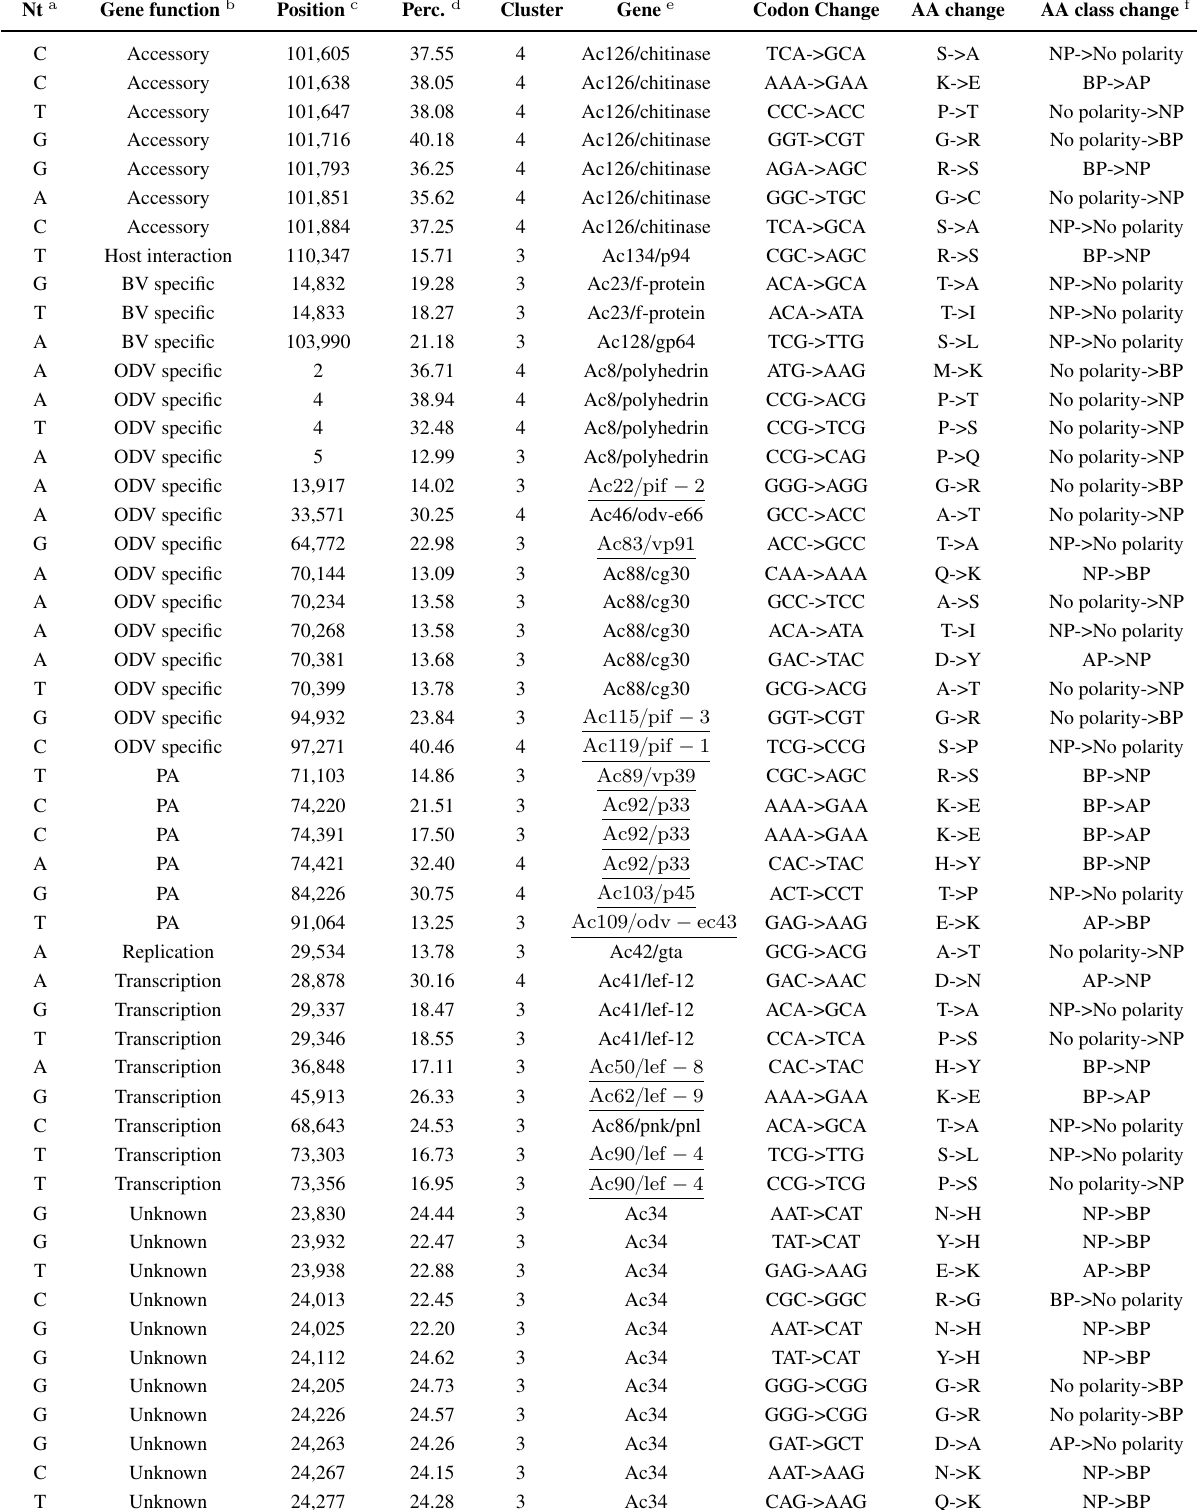
Table 3. Characteristics of the SNPs found in the clusters 3 and 4 on AcMNPV-WP10 genome population leading to a change in amino-acid